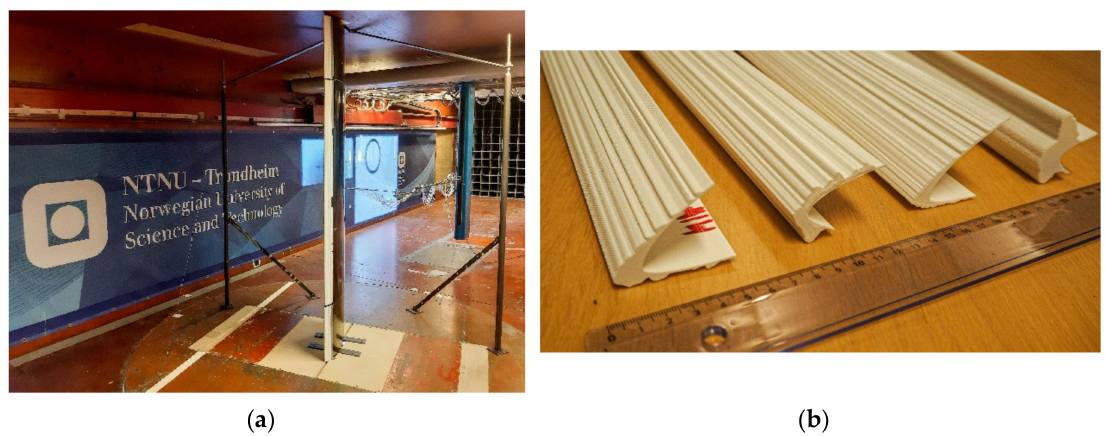
Figure 2. The wind tunnel set-up of the S826 consisting of dummy sections and the main part mounted vertically, with attached artificial ice shapes ( a ). The 3D printed ice shapes, from left to right: mixed, glaze, rime, and horn* ( b